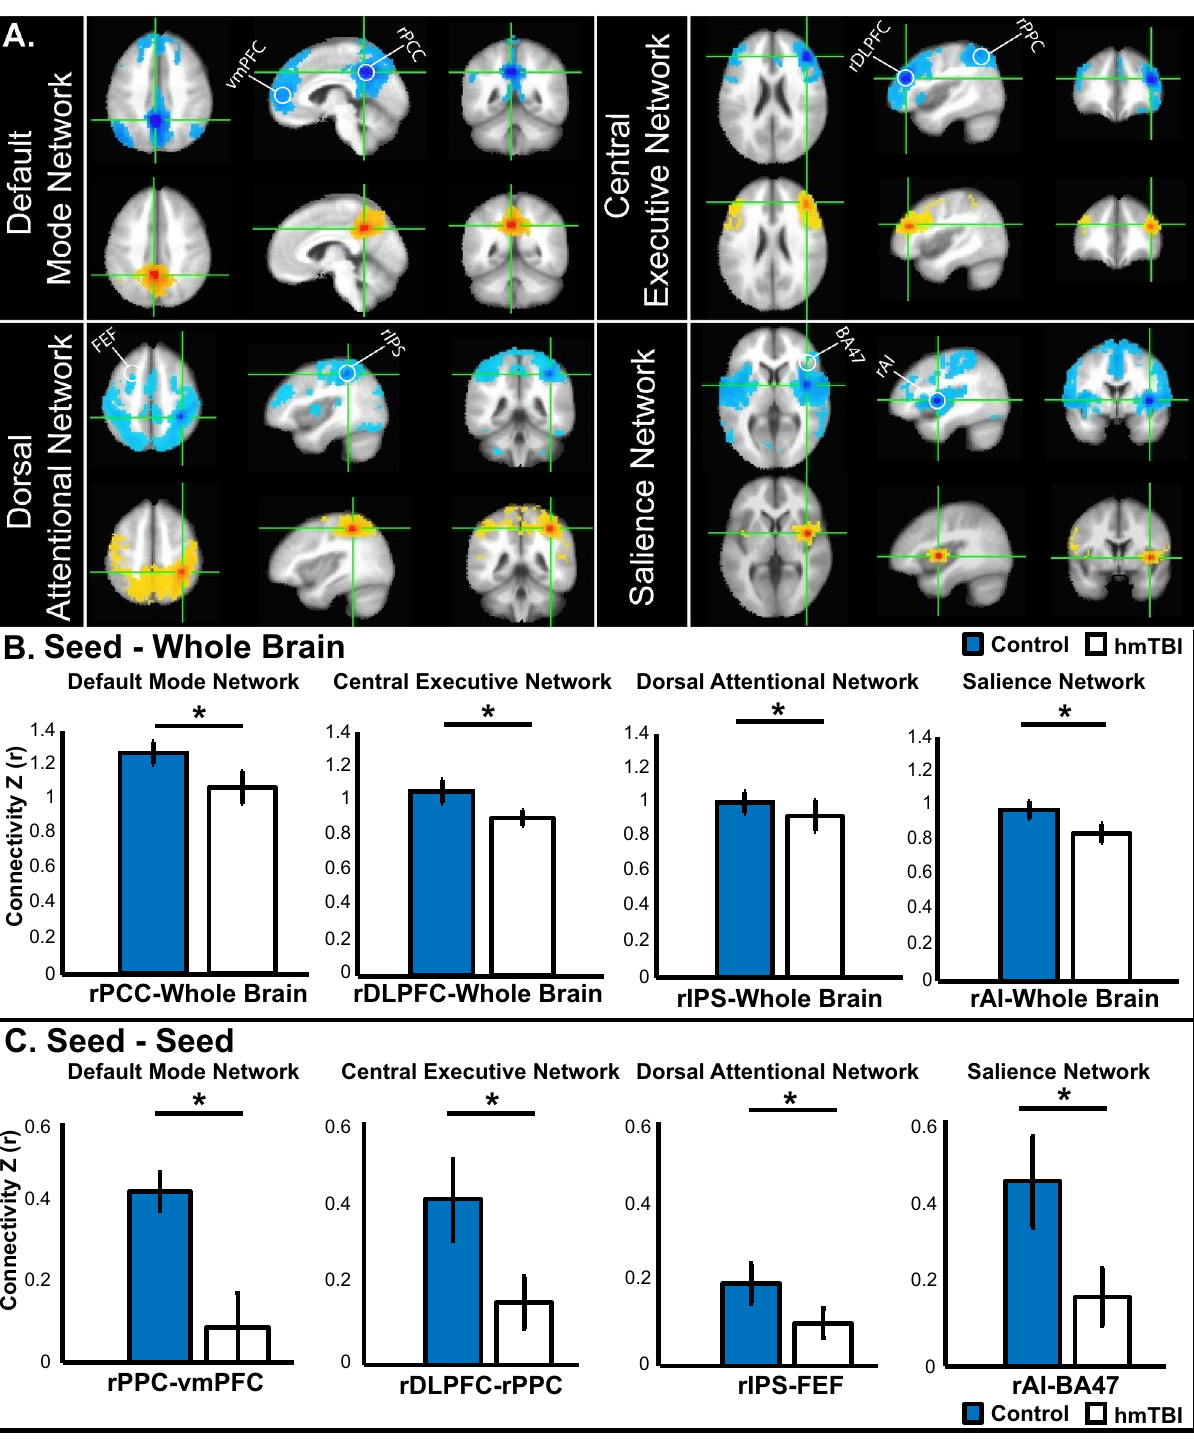
Figure 2. RsfMRI reveals weaker connectivity in participants with hmTBI. ( A ) DMN, CEN, DAN, and SN functional whole brain connectivity results show weaker connectivity in those with a hmTBI (yellow) compared to controls (blue). White circles identify seed locations. ( B ) Bar plots indicate z-score seed analysis based on seed-whole brain, indicating greater seed-whole brain connectivity in the control group. ( C ) Bar plots indicating z-score seed analysis showing connectivity between our seed-seed locations indicating greater connectivity in the control group. Error bars represent 95% confidence intervals. hmTBI history of mTBI, SR-mTBI sports related